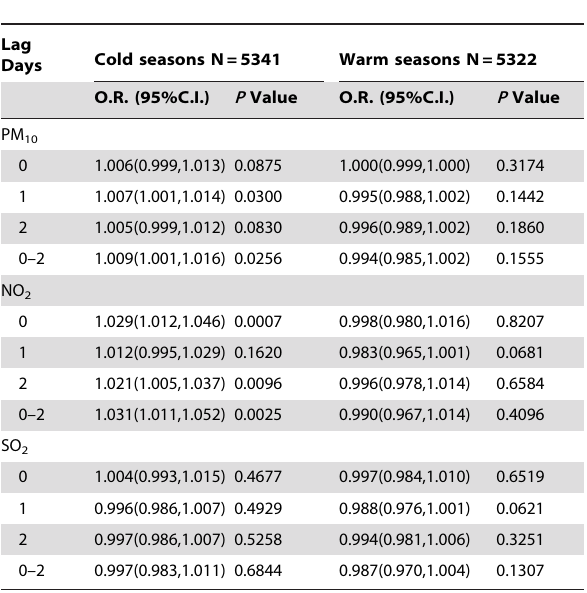
Table 3. The association of stroke admissions and air pollutants in cold (winter and spring) and warm (summer and fall) seasons for 10 m g/m 3 increases in pollutant level, adjusted for temperature and humidity, Wuhan, 2006–2008.